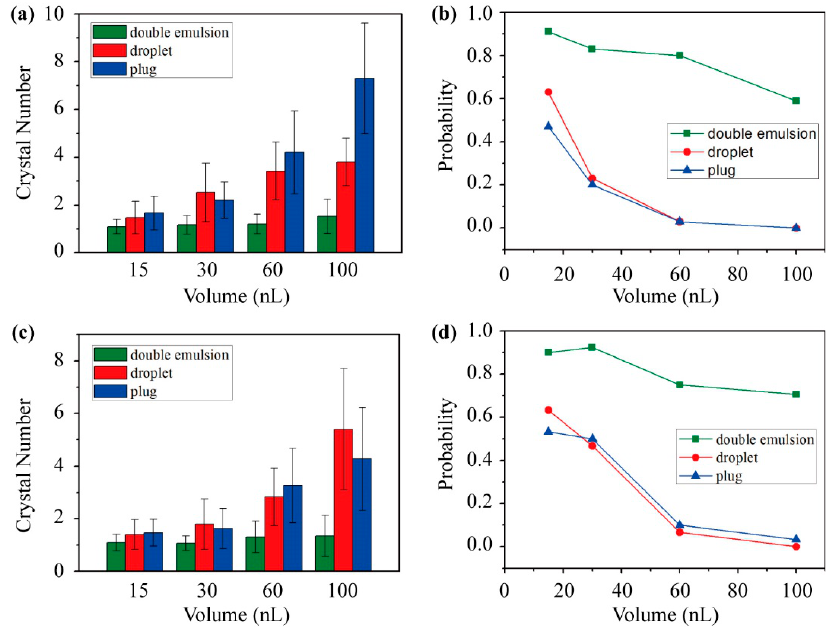
Figure 9. Effects of the protein solution volume in plugs, single droplets and double emulsions on protein crystallization. The number of protein crystals grown in each container with different protein solution volumes for ( a ) thaumatin and ( c ) horseradish peroxidase. The relationship between the probability of single crystals grown in the containers and different protein solution volumes for ( b ) thaumatin and ( d ) horseradish peroxidase. The model proteins: 20 mg/mL thaumatin and 5 mg/mL horseradish peroxidase.